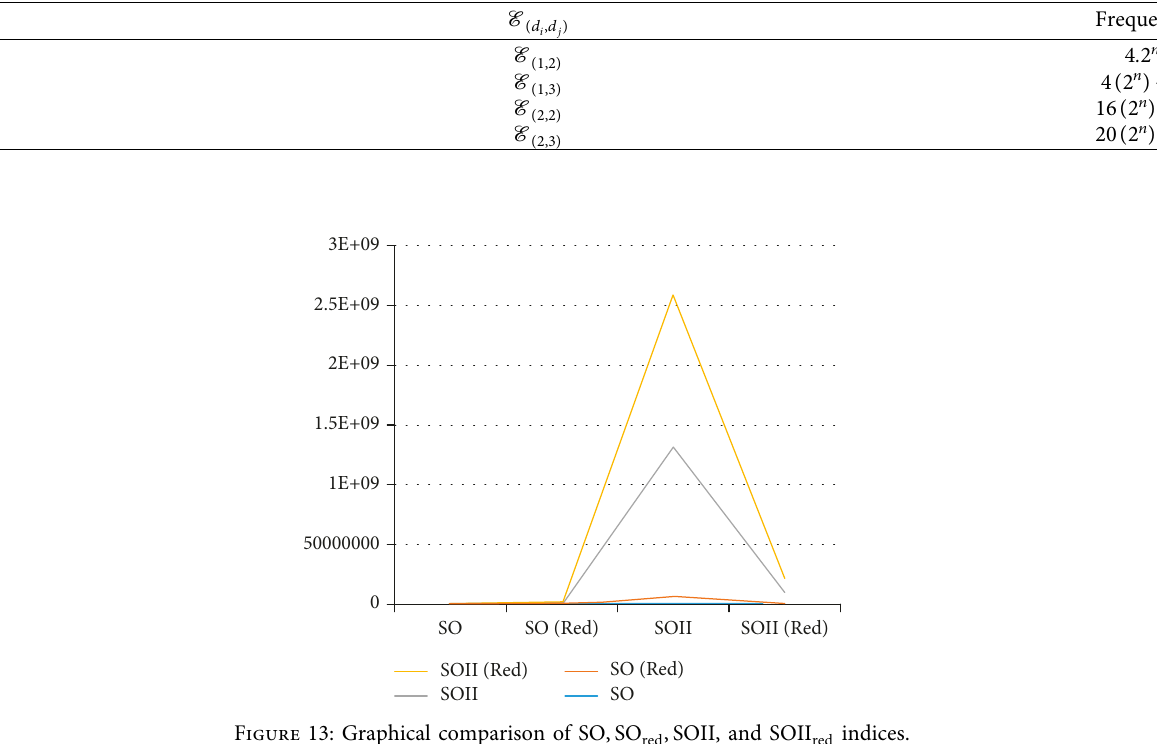
, SOII, and SOII red red